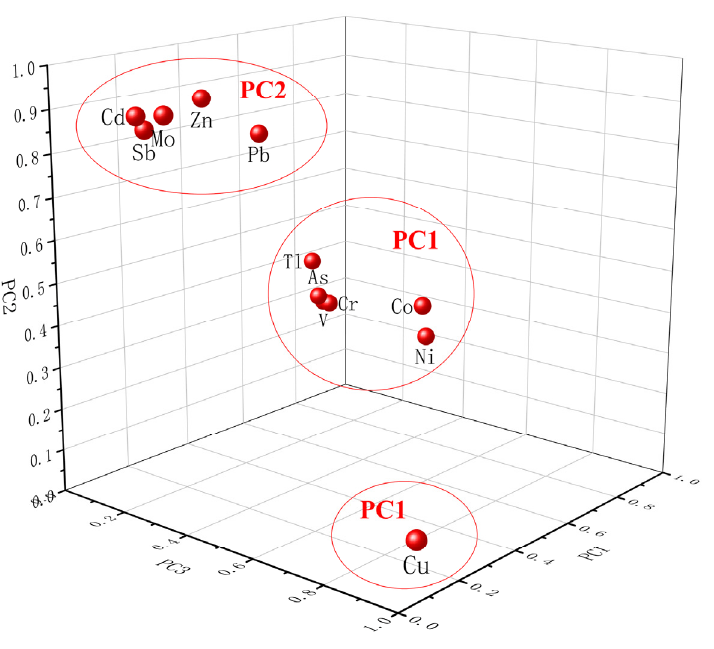
Figure 5. Component loading, scores, and confidence ellipse of the three principal components (PCs) for PTEs concentrations by principal component analysis (the number in the brackets indicates the proportion of total variance explained by each PC).